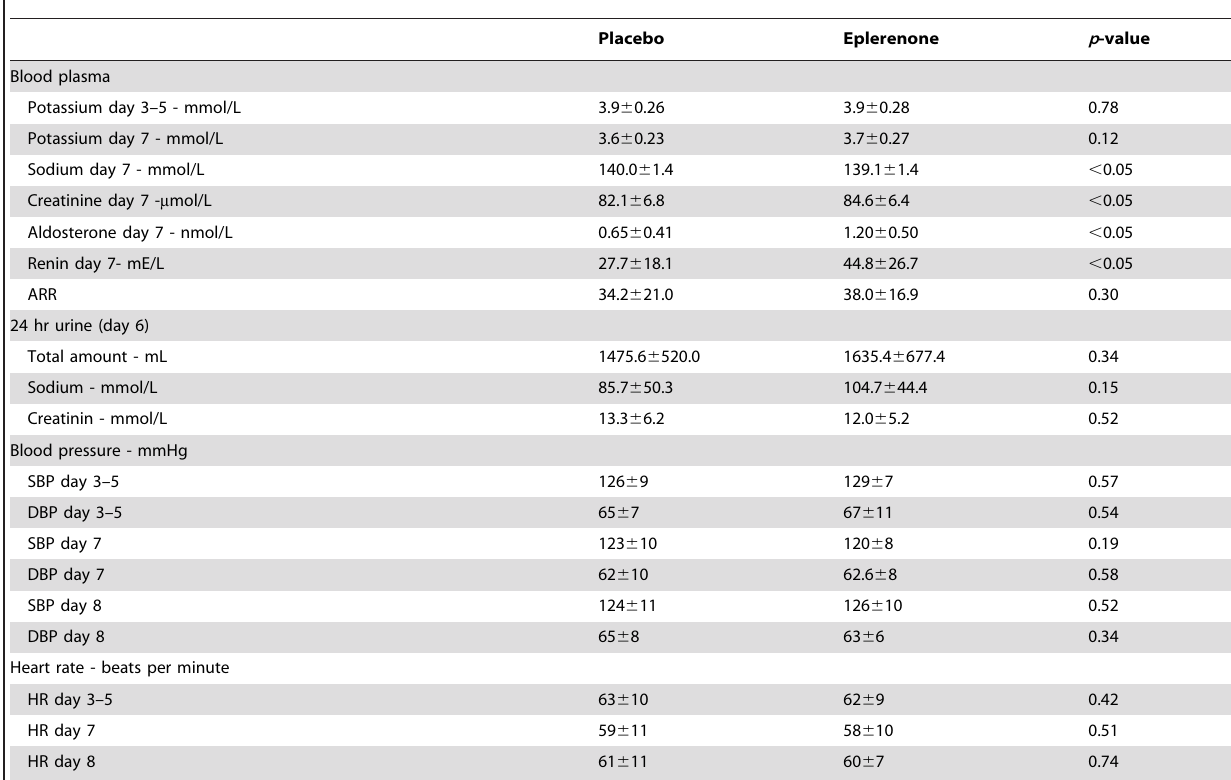
Table 2. Hemodynamic and laboratory values during the study.